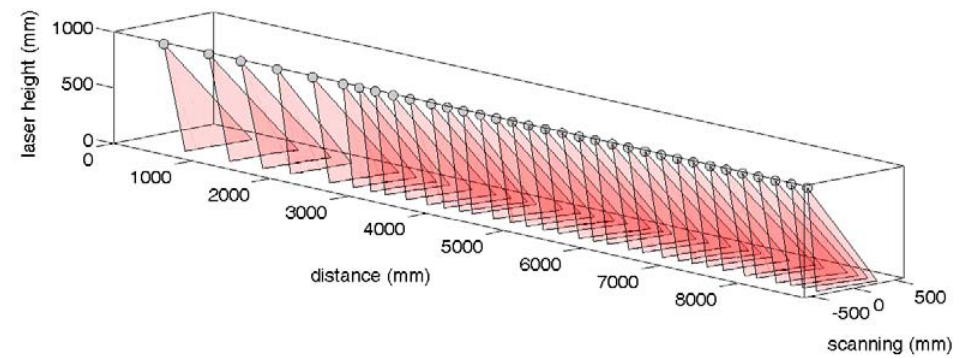
Figure 11. Three-dimensional representation example of the LIDAR scan plane in a forward